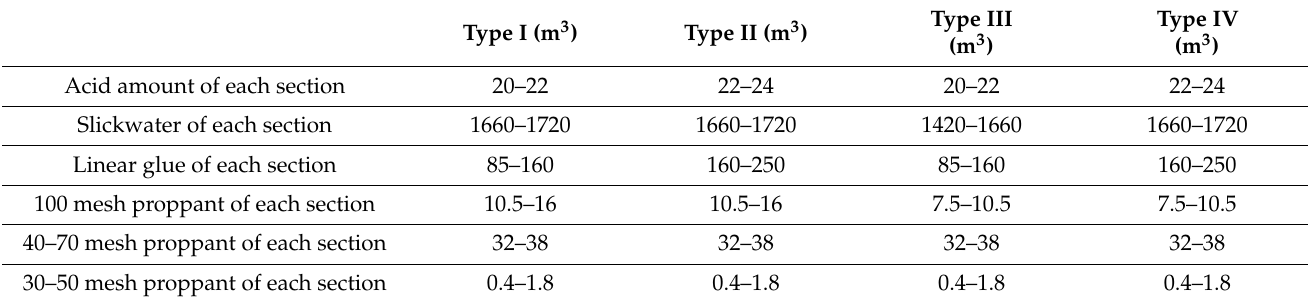
Table 5. Table of combinations of different parameter ranges.